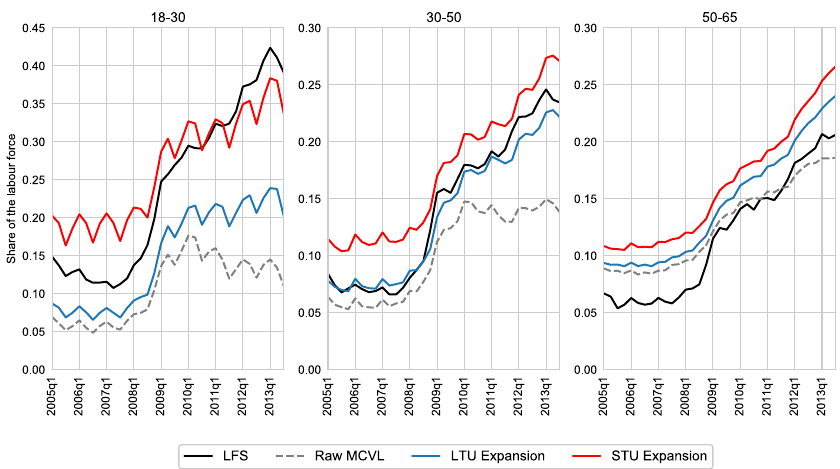
Fig. 10 Unemployment rates by age group. Source : MCVL and the